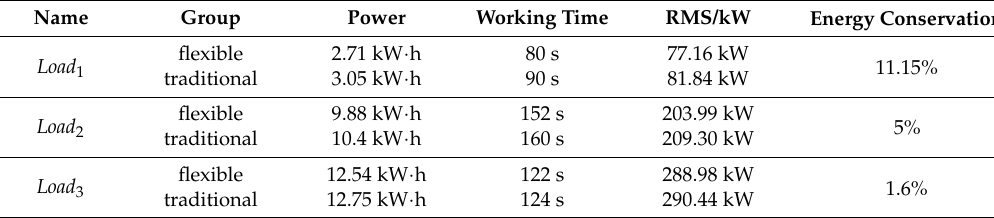
Table 5. The comparison of power consumption under normal condition.